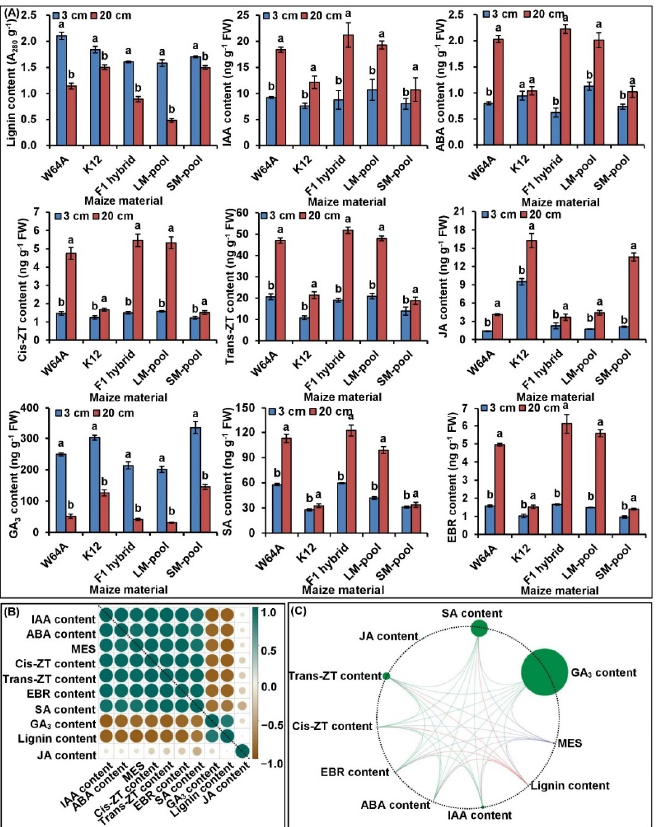
Figure 2. Nine physiological traits assay and the correlation relationship between all physiological traits and mesocotyl length (MES) from W64A and K12. ( A ) Statistics of lignin content, indole-3-acetic acid (IAA) content, abscisic acid (ABA) content, gibberellic acid 3 (GA 3 ) content, 24-epibrassinolide (EBR) content, cis-zeatin (Cis-ZT) content, trans-zeatin (Trans-ZT) content, jasmonic acid (JA) content, and salicylic acid (SA) content from mesocotyls of five maize materials under 3 and 20 cm sowing environments; different lowercase letters with a single maize material under different environments indicated a significant difference with p < 0.05 (ANOVA). ( B , C ) Correlation coefficient diagram and interactive ring correlation diagram (which were prepared using the Genescloud tool; https: //www.genescloud.cn (accessed on 6 April 2022)), among these, nine traits of maize materials under different